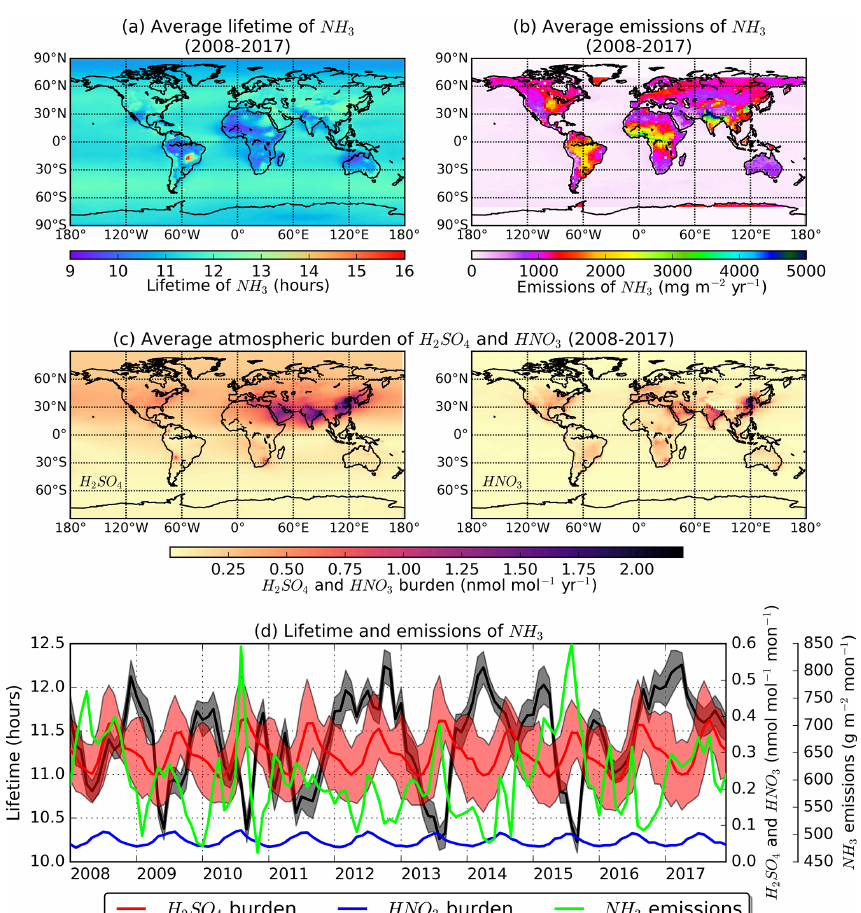
Figure 1. (a) The 10-year average model lifetime of ammonia calculated from LMDz-OR-INCA; (b) total annual emissions averaged over the 10-year period (NE emissions); (c) atmospheric burden of the reactants sulfuric acid and nitric acid calculated in the model; and (d) monthly time series of lifetime (black), ammonia emissions (green), sulfuric (red) and nitric acid column concentrations (blue) for the whole 10-year